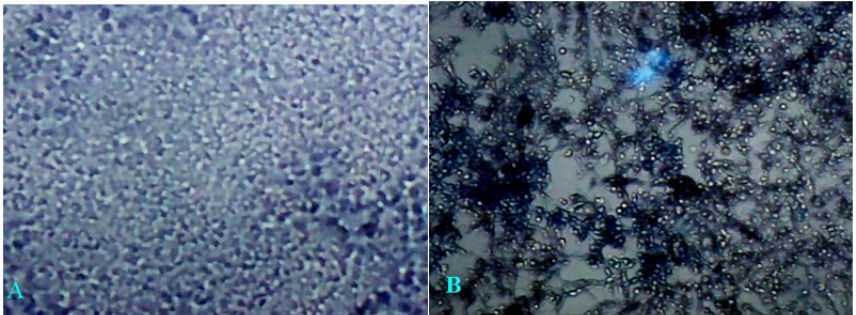
Figure 7. Characteristic images of Hep-2C cells before ( A ) and after ( B ) MTT treatment. Cells with MTT solution showed dark purple crystal formations inside of the cells. Table 5. IC 50 data of synthetic compounds at 24, 48 and 72 h.